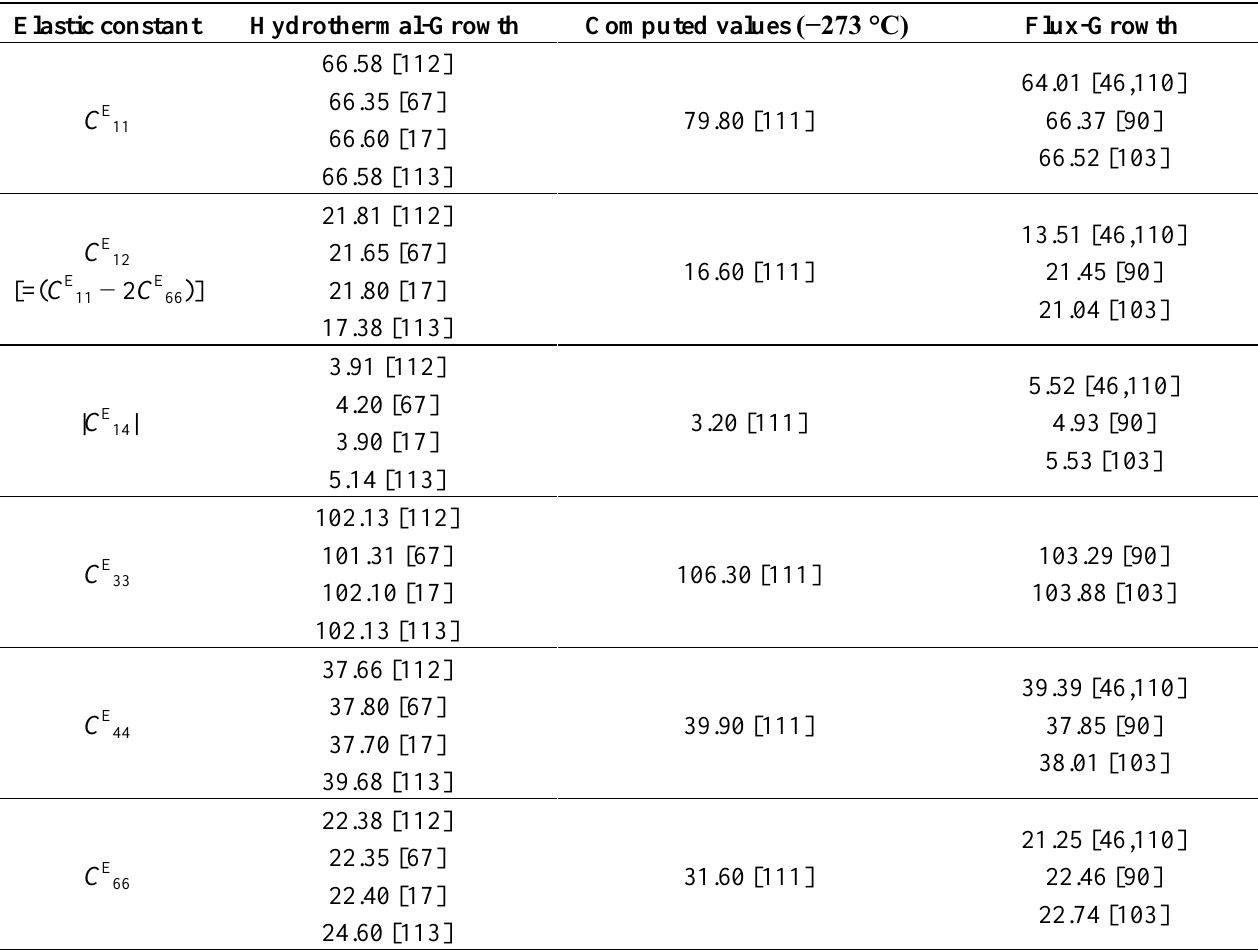
[GPa] of α-GaPO IJ